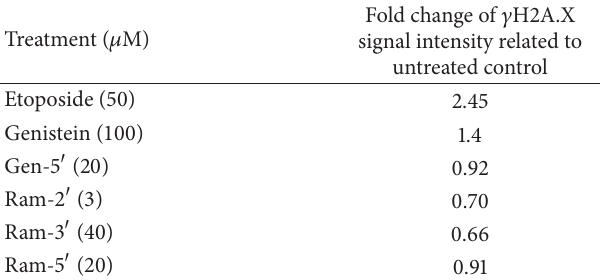
Table 3: 𝛾 H2A.X staining in HCT116 cells.